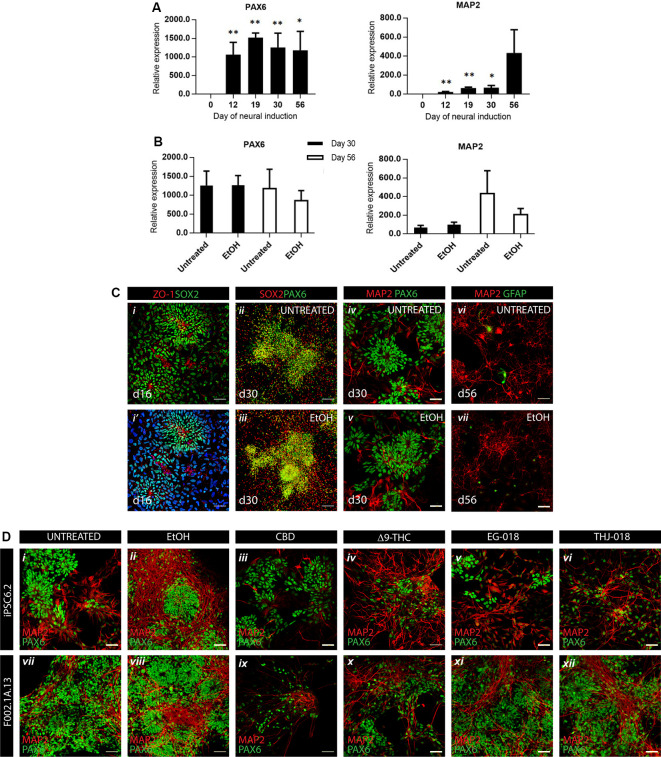
Efficient neural differentiation of hiPSCs and the effect of cannabinoid exposure. (A) qRT-PCR analysis of neural progenitor (PAX6) and neuronal (MAP2) mRNA expression levels relative to GAPDH at indicated timepoints. Data were analyzed by unpaired t-test, *p < 0.05, **p < 0.01; error bars represent standard error of the mean (SEM). (B) qRT-PCR analysis of PAX6 and MAP2 mRNA levels in untreated vs. vehicle-treated (0.01% EtOH) cultures showing no significant differences by unpaired t-test. Data in panels (A,B) were obtained from four independent experiments using iPSC6.2 cells. (C) Immunofluorescence for neural progenitor, neural and glial markers at different timepoints showing efficient neural commitment and differentiation of hiPSCs. Scale bars in panels (i,i’), 100 μm. Scale bars in panels (ii–vii), 50 μm. (D) Immunofluorescence at day 30 for neural progenitor marker PAX6 and neuron-specific microtubule-associated protein MAP2 in untreated (i, vii), vehicle-treated (ii, viii), and exposed to cannabinoids from day 19 to day 30 cultures (iii–vi, ix–xii), in two different iPSC lines, iPCS6.2 (male donor) and F002.1A.13 (female donor). Scale bars: 50 μm.